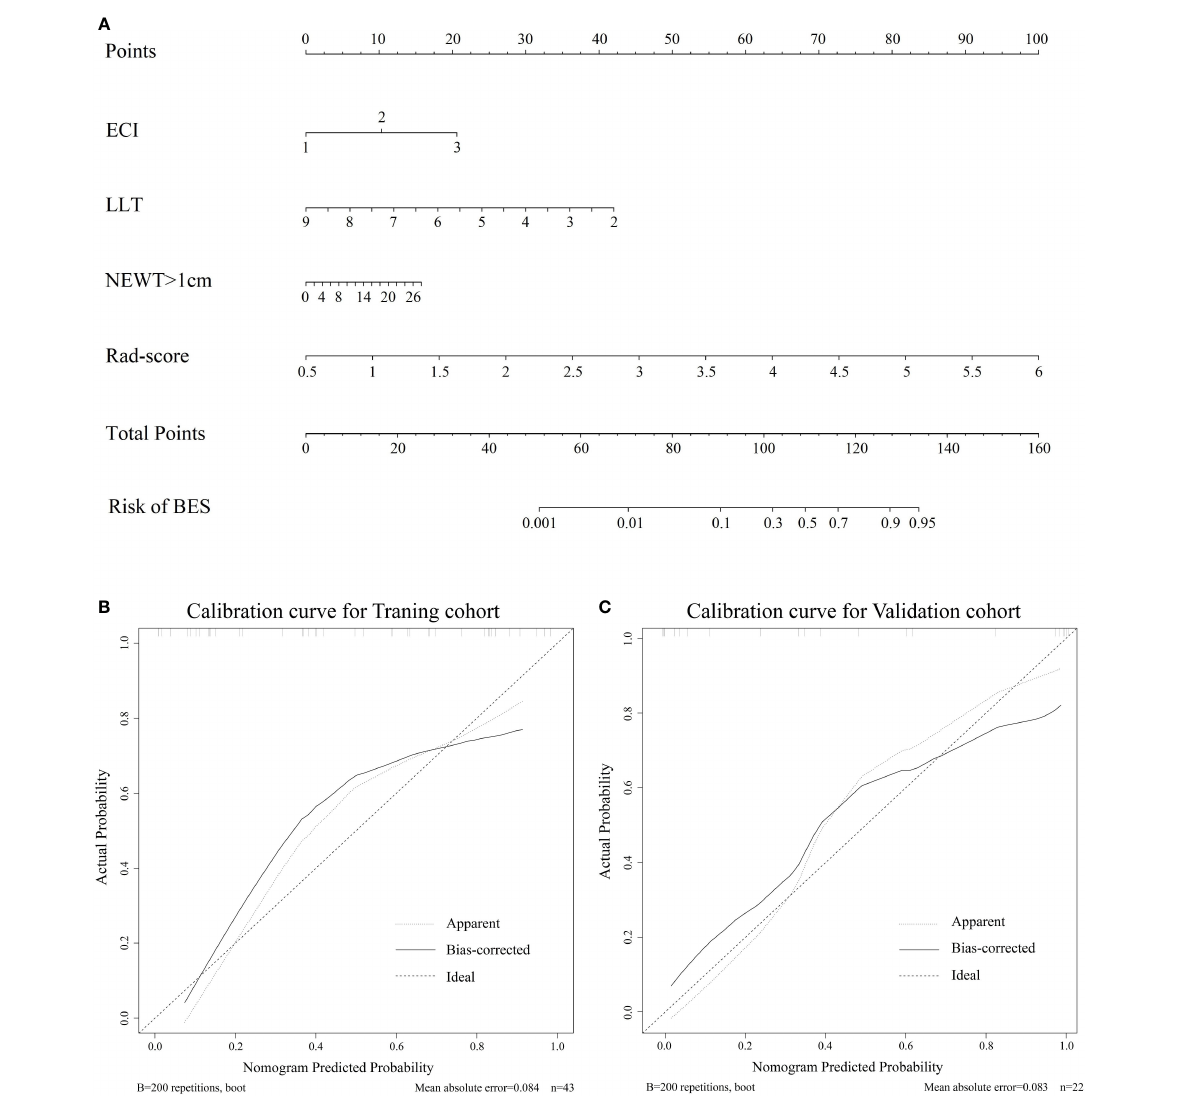
FIGURE 5 (A) . The nomogram for the prediction of BES. The constructed nomograms were used to estimate the risk of BES for individual ESCC patients. Calibration curves of the combined nomogram in the training cohort (B) and validation cohort (C) . The calibration curves describe the calibration of the combine nomogram in terms of the conformity between the predicted risk of BES and observed BES outcomes. The 45° dotted line represents a perfect prediction, the solid lines represent the bias-corrected performance of the combine nomogram. BES,